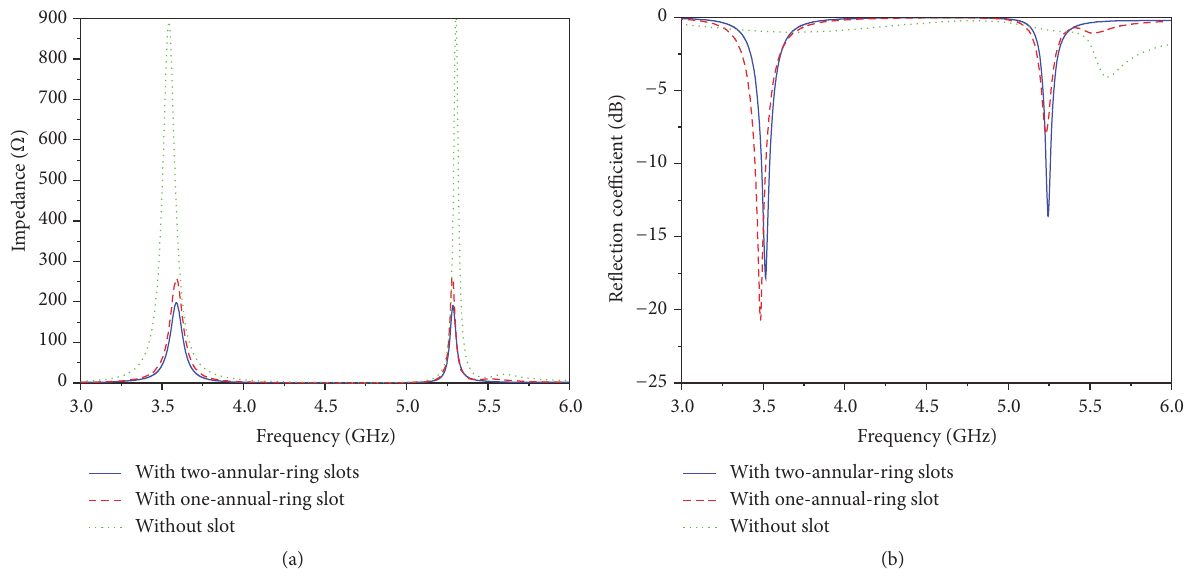
Figure 6: Simulated (a) input impedance and (b) 𝑆 -parameters feeding with no slot, one-annular-ring slot, and two-annular-ring slot, respectively.